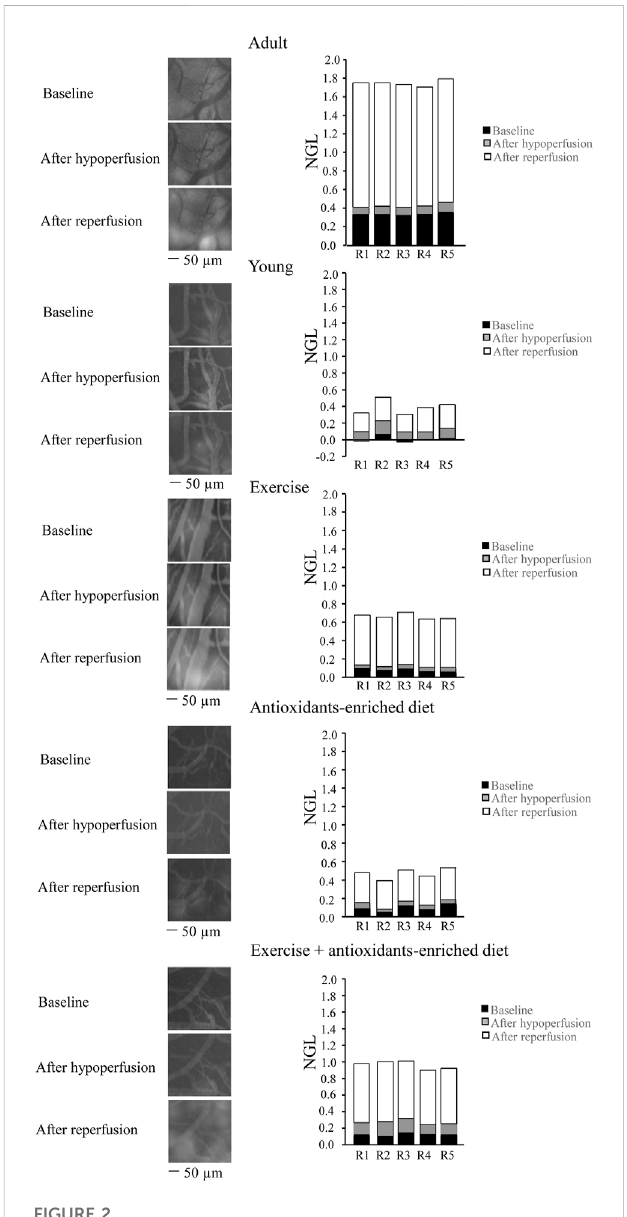
FIGURE 2 Changes in the increase of microvascular permeability evaluated in vivo in baseline conditions (baseline), after hypoperfusion and at the end of reperfusion in the different experimental groups. Right reports the graphs of the variations of the microvascular permeability quanti fi ed by the normalized gray levels (NGLs) for each animal (R1 – R5), while left reports the corresponding video images obtained using a fl uorescence microscope in an SHR belonging to each experimental group. n = 5 for each